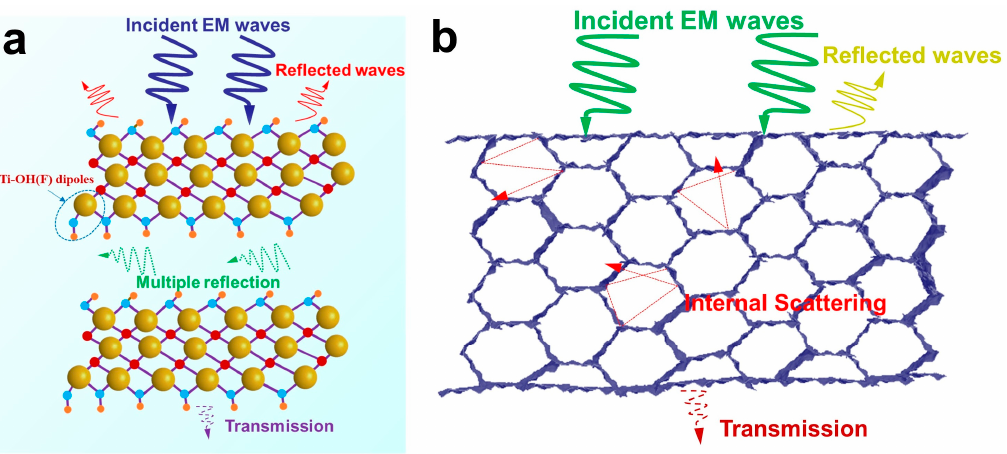
Figure 3. Schematic illustration of the electromagnetic waves transfer across the ( a ) MXene film and ( b ) 3D porous MXene film. ( b ) 3D porous MXene